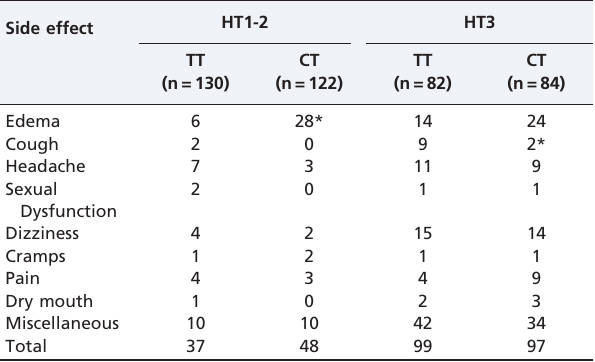
Table 4 - Number of patients showing side effects according to the antihypertensive regimen used – traditional treatment (TT) versus current treatment (CT) - in patients with grade 1 or 2 (HT1-2) or grade 3 (HT3)